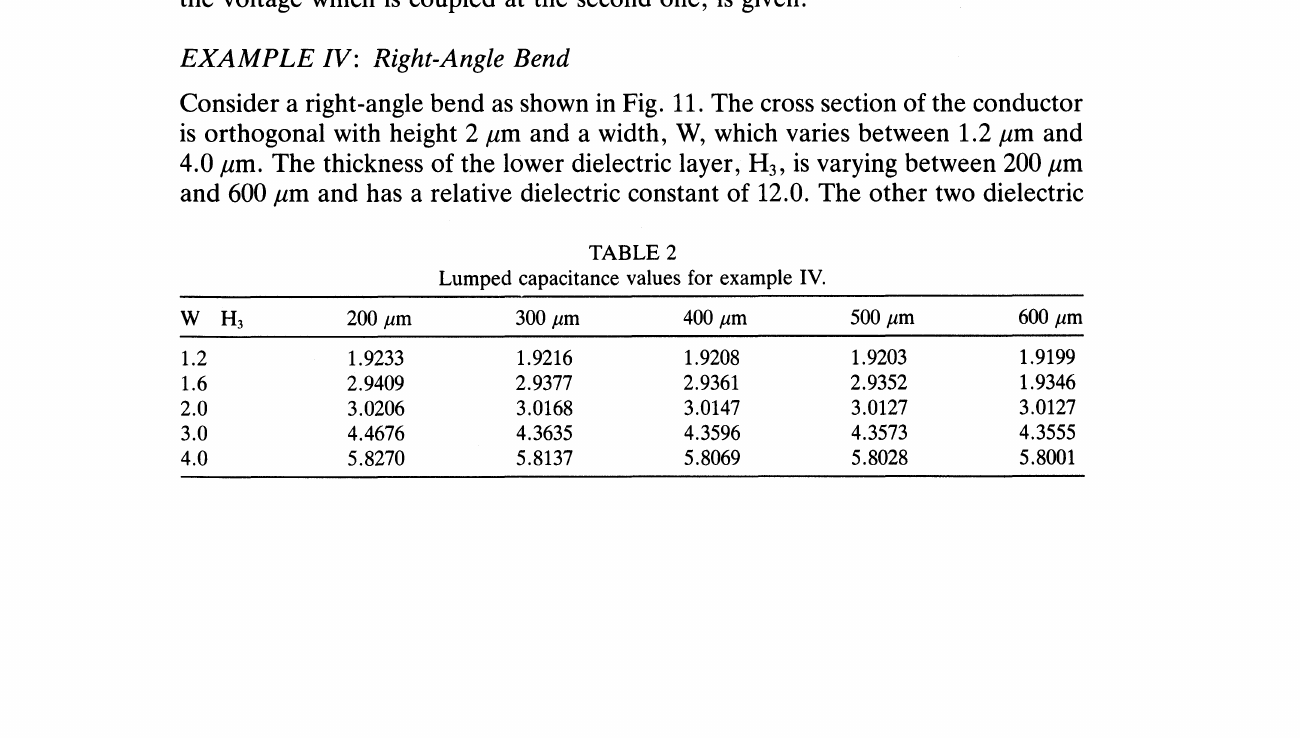
Lumped capacitance values for example